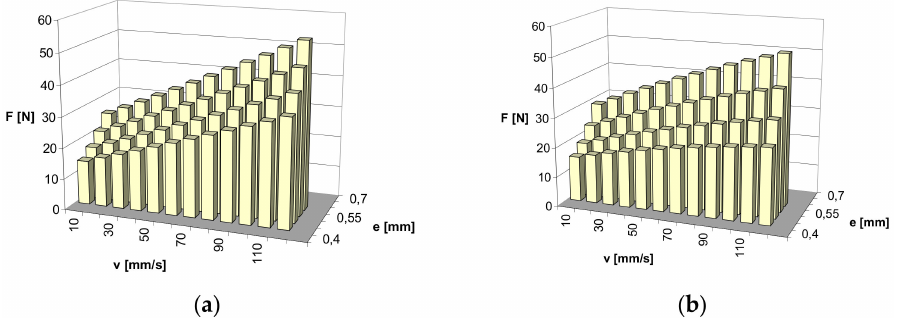
Figure 8. Approximated results of friction force measurements: ( a ) FKM pure material; ( b ) FKM material with graphite